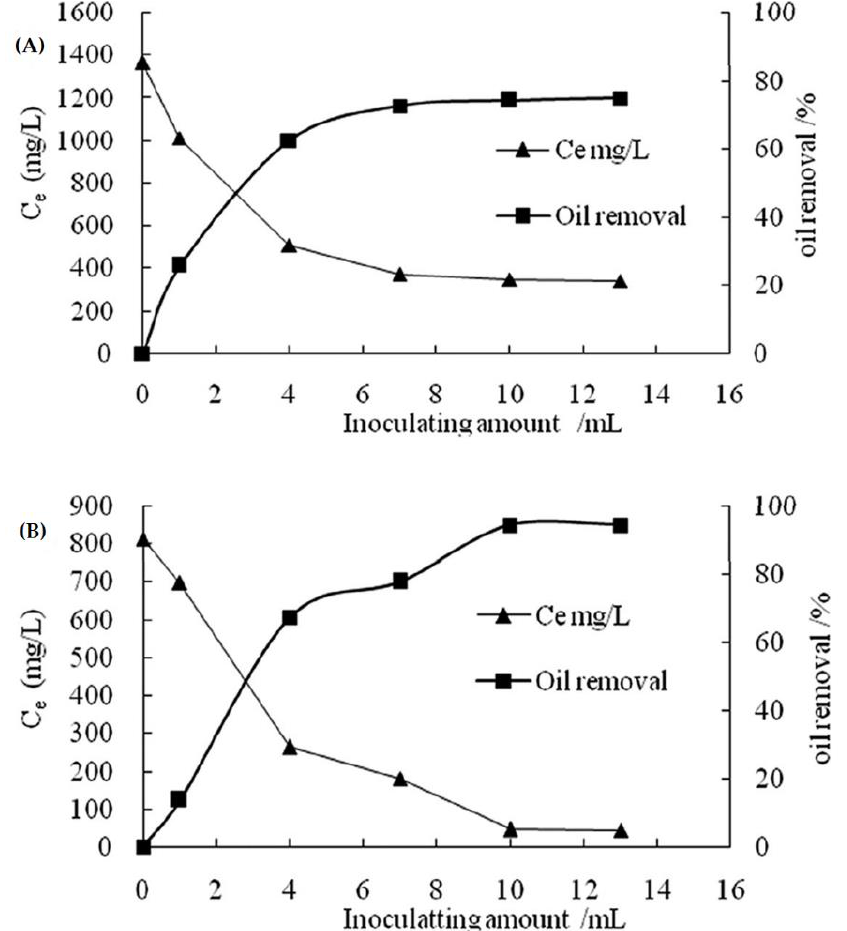
Figure 7. The impact of the number of bacteria inoculated on the biodegradation of Diesel Oil (LD) ( A ) and Heavy Oil (HO) ( B ). The x-axis (C e ) is the concentration of the residual oil after microbial degradation. Y-axis is the amount of inoculate per mL. Adapted from Zhou et al. [118].